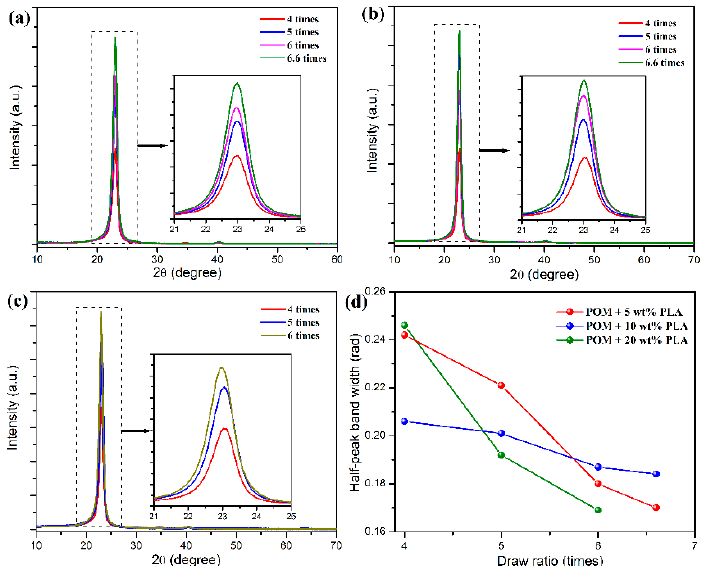
Figure 9. Azimuthal intensity distributions on the equator plane of XRD patterns of POM / PLLA bicomponent fibers containing ( a ) 5, ( b ) 10, and ( c ) 20 wt % PLLA at different draw ratios; ( d ) plots of half-peak band width as a function of draw ratio for POM/PLLA bicomponent fibers.